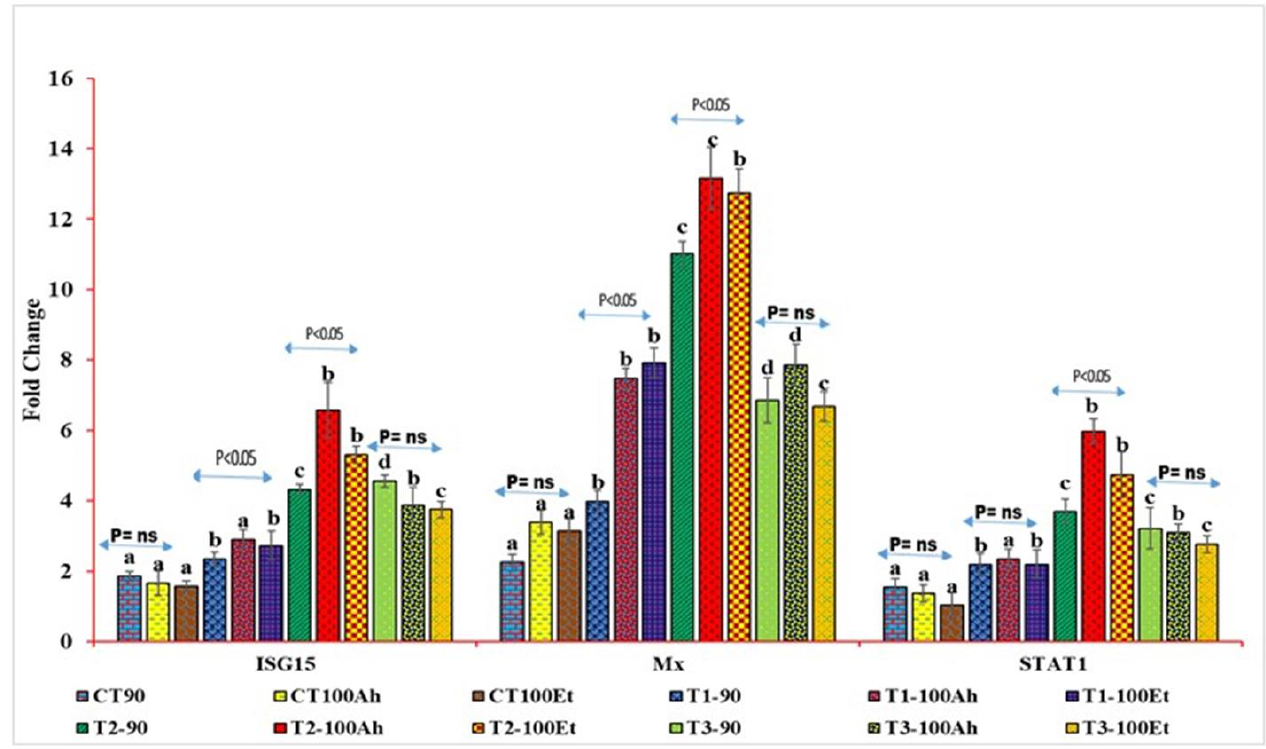
Figure 4. qPCR analyses of three immunogenic genes (Mx, STAT1, and ISG15) during the feeding trial followed by the challenge study by two bacterial isolates, Edwardsiella tarda and Aeromonas hydrophila. Here, we conducted statistical analysis between and within the treatments. The superscript above the same color column shows a comparison between the treatments, and significance with an arrow ( p < 0.05 representing significance at 5 % level of significance and ns represents insignificance) shows comparison among the treatments. CT, T1, T2, and T3 suffixed with 90 shows the feed trial of 90 days with treatment groups, and 100Ah and 100Et shows the challenge study with bacterial isolates, Edwardsiella tarda and Aeromonas hydrophila , for 10 days (90–100